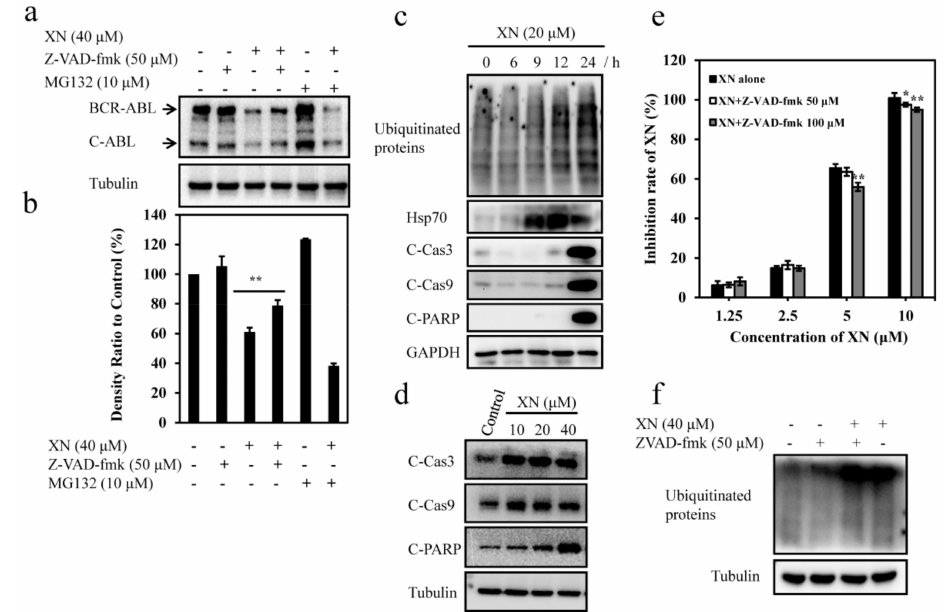
Figure 5. XN induces caspase-dependent BCR-ABL degradation and apoptosis in K562 cells. ( a ) XN decreases BCR-ABL protein in a caspase-dependent manner. K562 cells were untreated or pretreated for 1 h with 50 µ M of pan caspase inhibitor Z-VAD-fmk or proteasome inhibitor MG132 (10 µ M) either alone or in combination with XN (40 µ M) for 24 h. Expressions of BCR-ABL were determined by Western blotting. Tubulin was used as a loading control. ( b ) Histograms show the relative intensity of BCR-ABL bands. Data are presented as mean ± SD (n = 3). ** p < 0.01, versus control. ( c ) XN inhibits the ubiquitin proteasome system activities in K562 cells. Cells are treated with 20 µ M of XN for di ff erent time periods (6, 9, 12, and 24 h), followed by detection of ubiquitinated proteins, Hsp70, C-Cas3, C-Cas9, and C-PARP. ( d ) XN induces caspase activation and apoptosis. K562 cells were incubated with indicated concentrations of XN for 24 h, and cell lysates were then immunoblotted to assess the changes of C-Cas3, C-Cas9 and C-PARP. ( e ) Pan caspase inhibitor Z-VAD-fmk attenuates XN-induced cell death. K562 cells were pretreated with or without Z-VAD-fmk for 1 h followed by incubation with various concentrations of XN for 72 h, and then cells were subjected to MTT assay. Data are expressed as mean ± SD (n = 3). * p < 0.05, ** p < 0.01, versus XN alone. ( f ) Pan caspase inhibitor Z-VAD-fmk has no e ff ect on ubiquitinated proteins. Cells were pretreated with or without Z-VAD-fmk for 1 h, followed by incubation XN (20 µ M) for 24 h, and ubiquitinated proteins were detected by Western